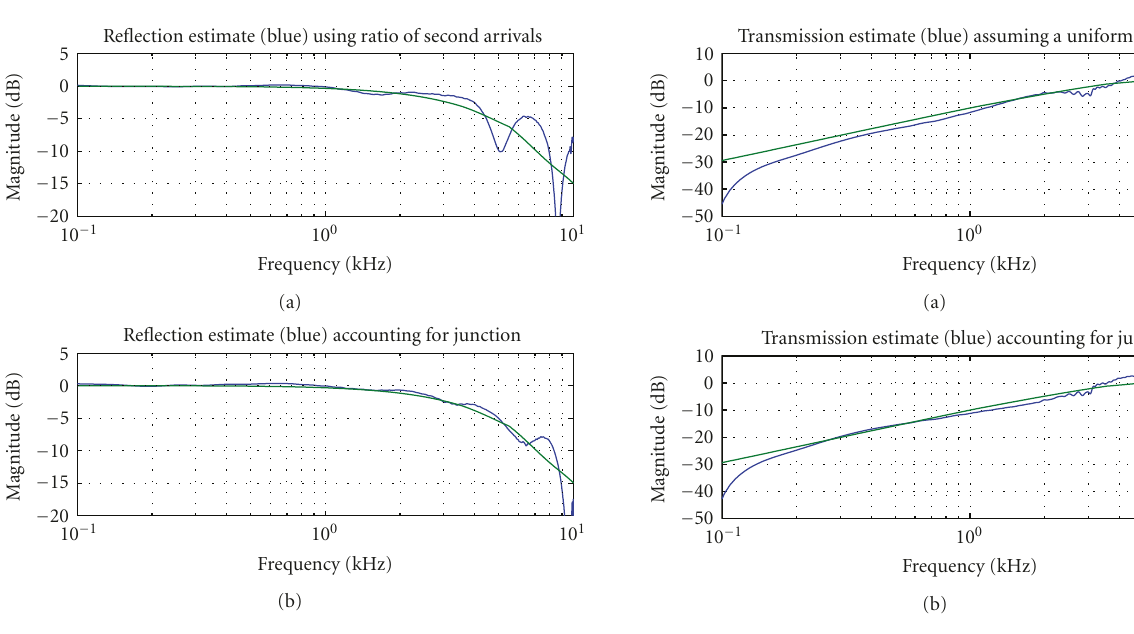
Figure 11: A signal flow diagram of two adjoined cylindrical tubes (instrument I3), with a two-port scattering junction due to the di ff erence in the tube’s cross-sectional area. With the junction removed (or equivalently by setting k = 0), the diagram is equivalent to the instrument waveguide model in Figure 1.